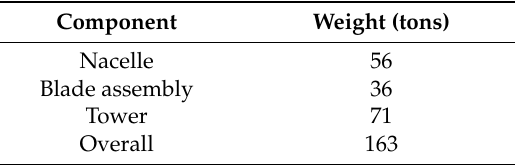
Table 2. General Electric 1.5 MW Model